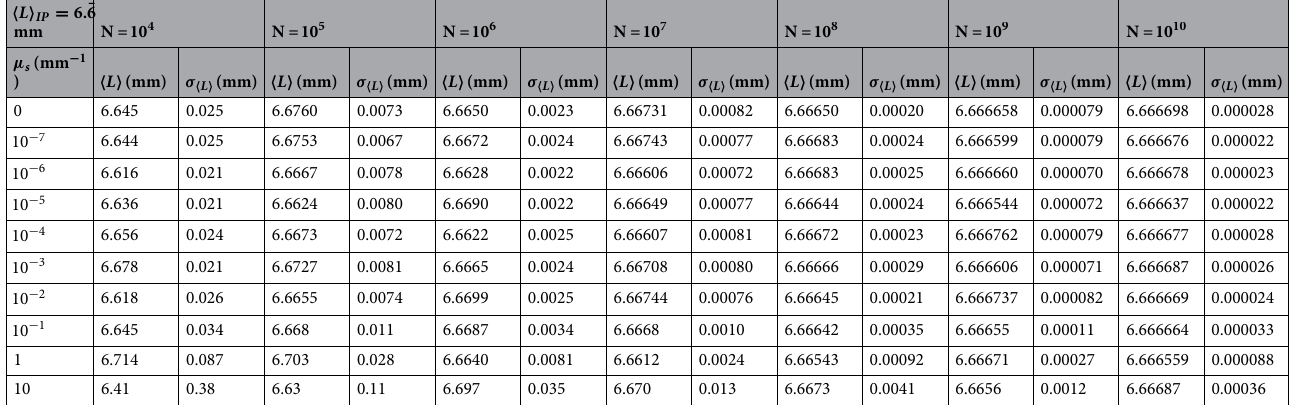
5 mm and n r 1 for different values of the scattering coefficient µ s = =